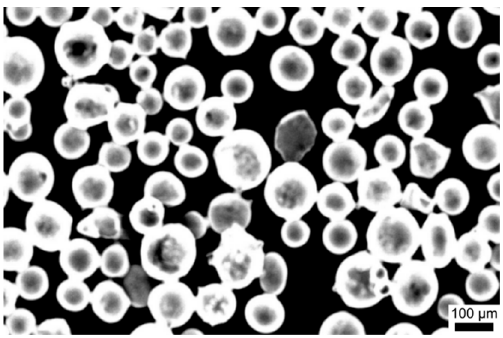
Figure 1. The morphology of Ni-base alloy powders. Table 1. Chemical composition of 316L stainless steel and powder (wt%).